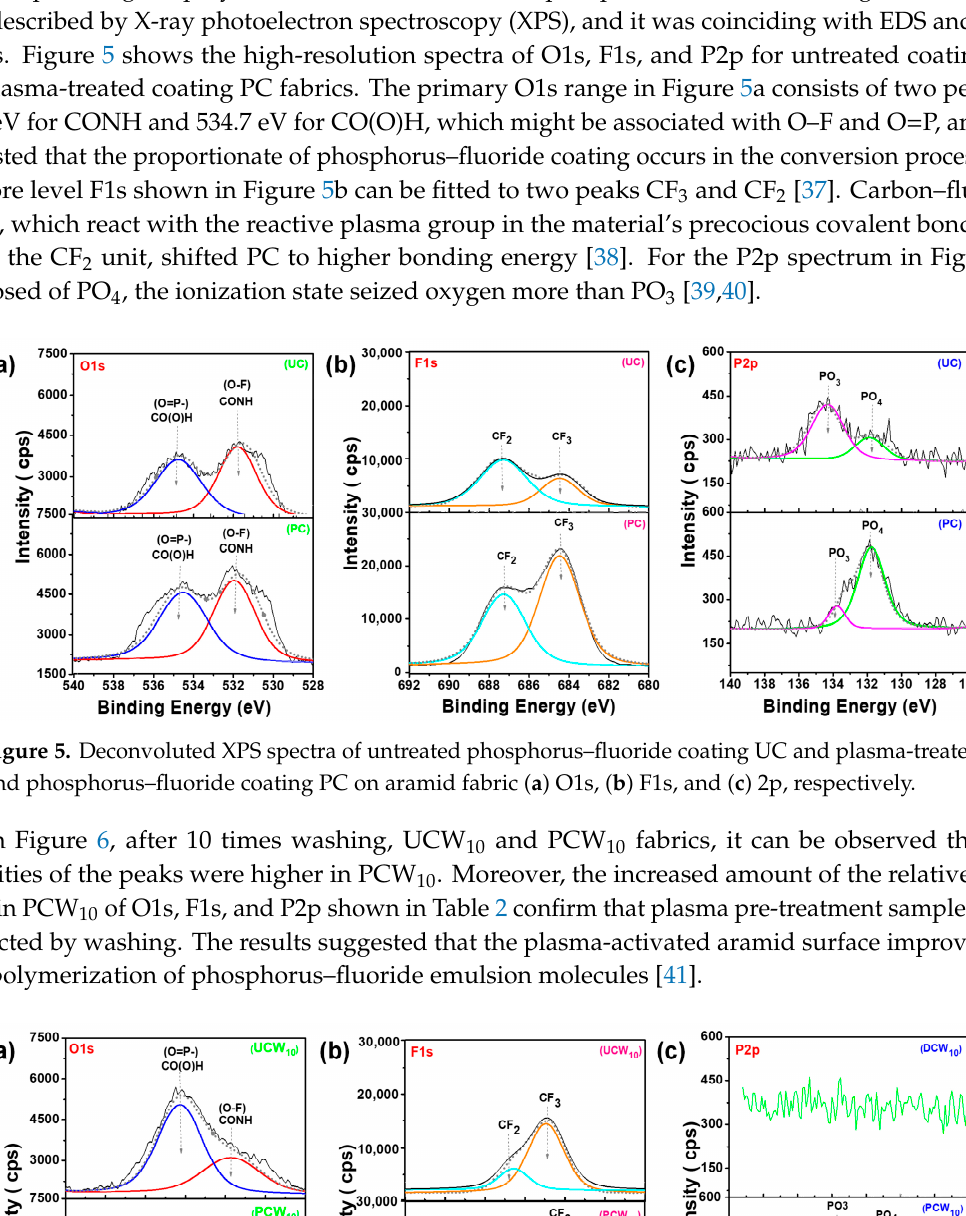
Figure 6. Deconvoluted XPS spectra of untreated phosphorus–fluoride coating UCW 10 and plasma-treated and phosphorus–fluoride coating PCW 10 after 10 times washing on aramid fabric ( a ) O1s, ( b ) F1s, and ( c ) P2p, respectively.